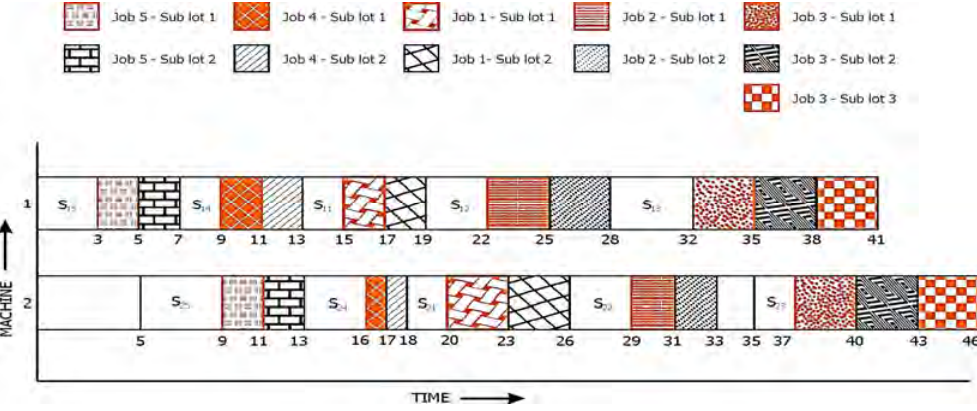
Fig.5 - Schedule for the sequence